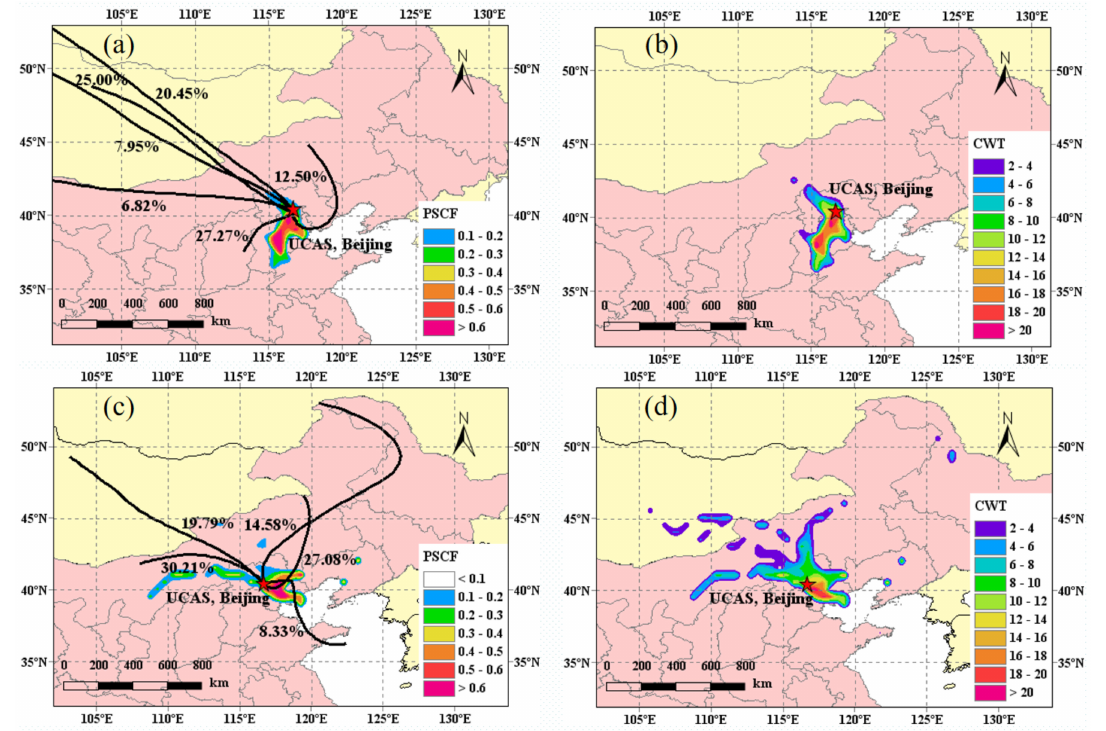
Figure 6. The 48 h backward trajectories, potential source contribution function (PSCF), and concen- tration weighted trajectory (CWT) from Beijing during ( a , b ) P1 and ( c , d )